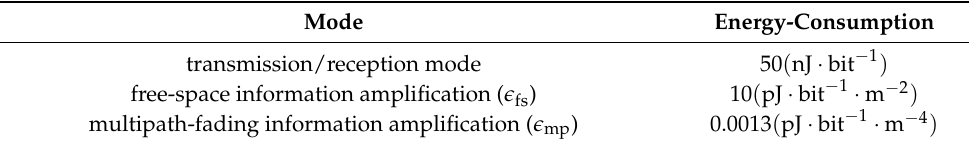
Table 2. The energy consumption in radio transmission and reception mode. Mode